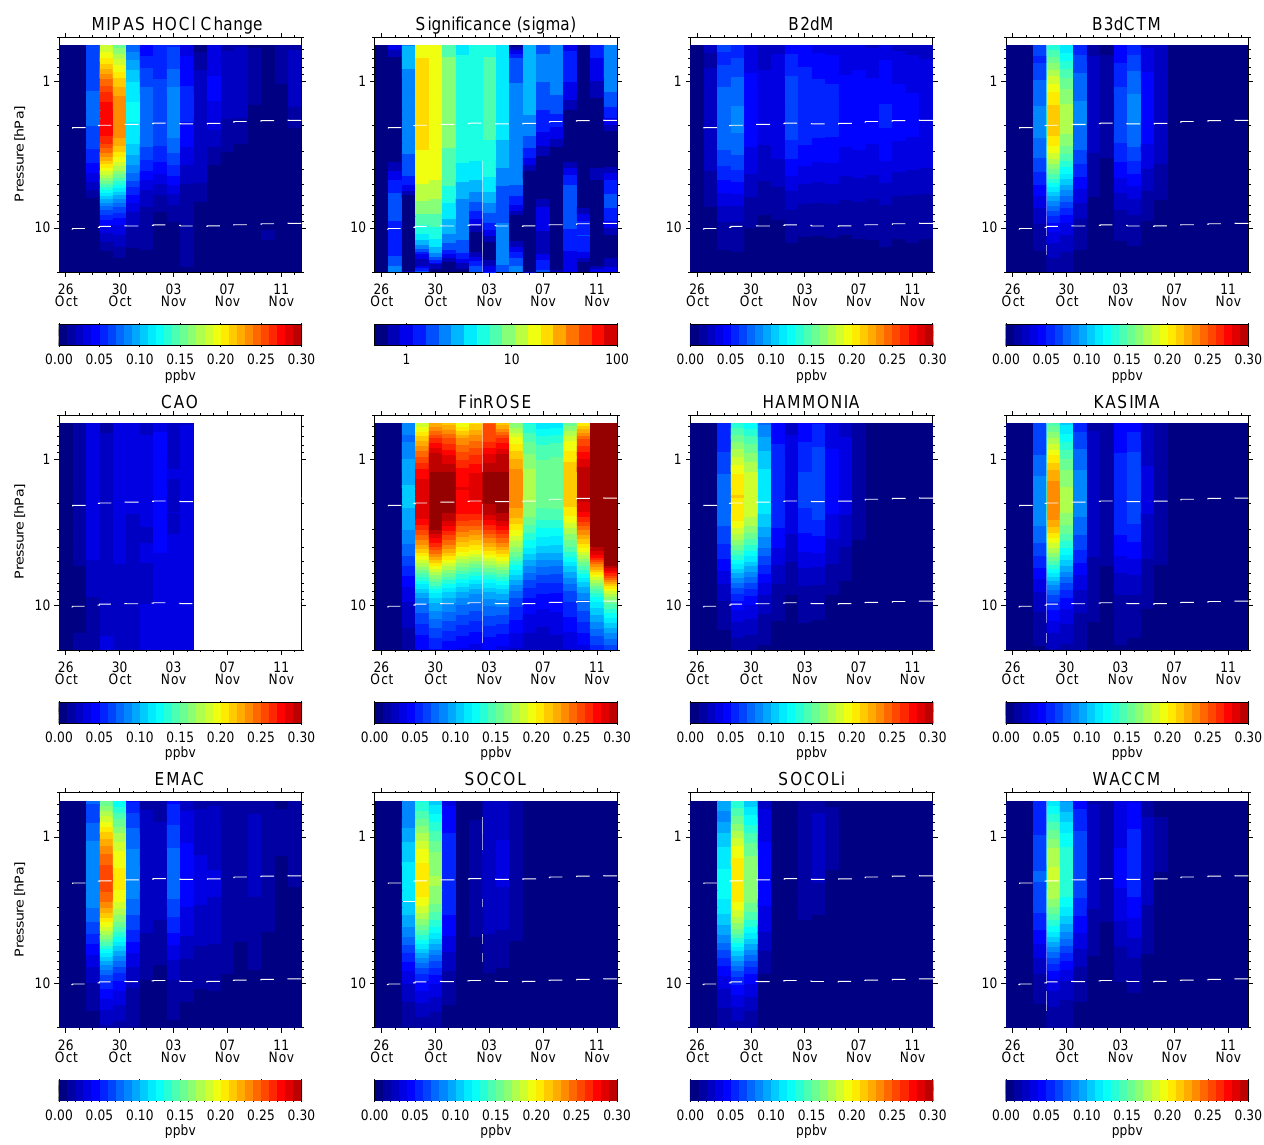
Fig. 34. Temporal evolution of area-weighterd averages of relative HOCl changes with respect to 26 October 2003 in MIPAS observations and model simulations at 70–90 ◦ N, as well as differences between modeled and observed averages. The significance of observed HOCl changes (in units of σ ) is shown in the upper second panel (from the left).